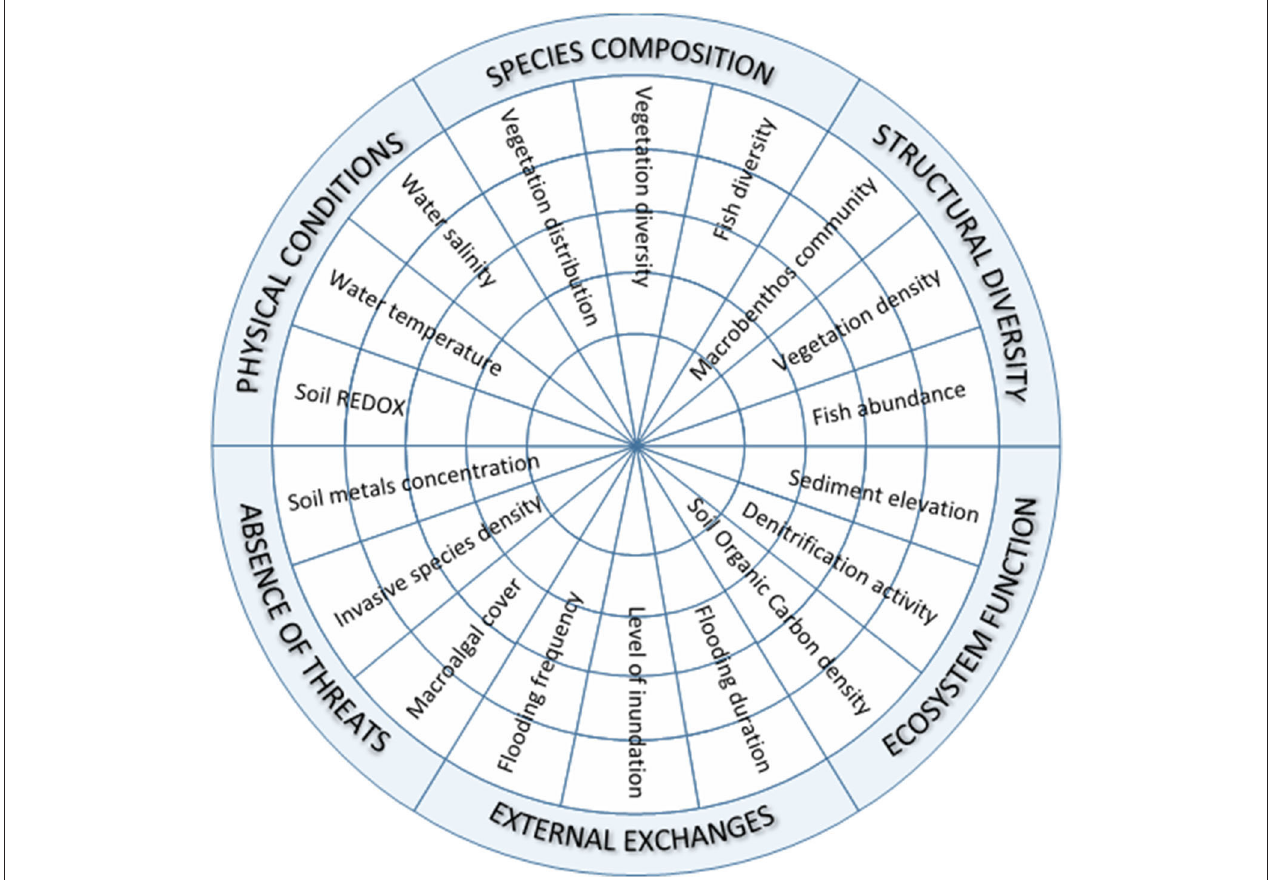
FIGURE 5 | Coastal wetlands recovery wheel including indicators found in the scientific